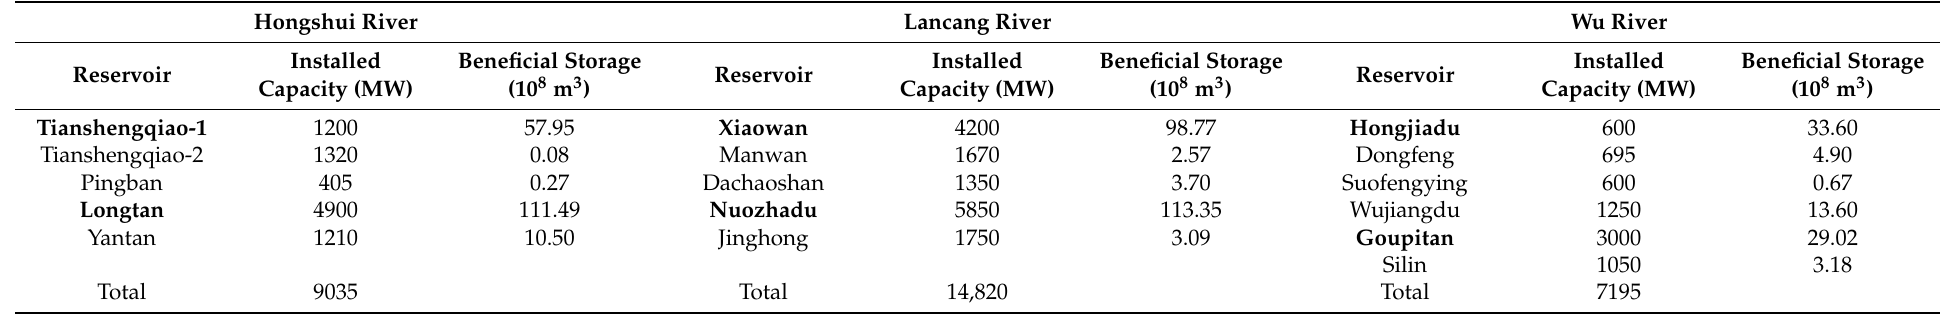
Table 1. Characteristics of the studied hydropower